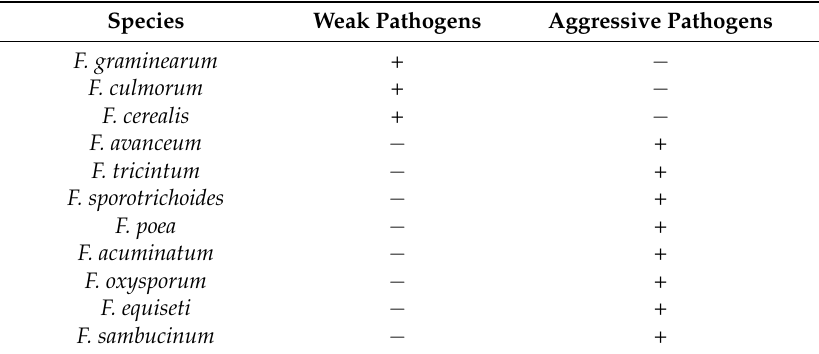
Table 1. Fusarium species division on weak and aggressive pathogens [14]. Species Weak Pathogens Aggressive Pathogens F.